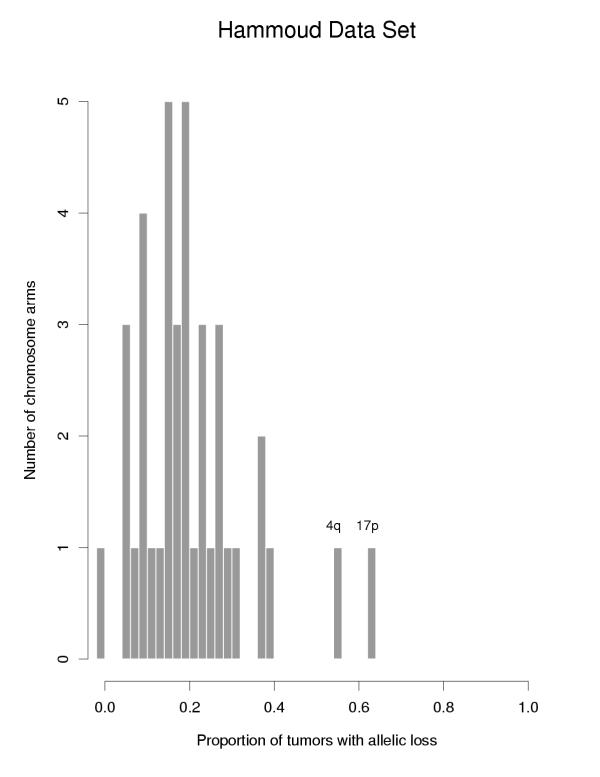
Histogram of allelic loss for the Hammoud data set